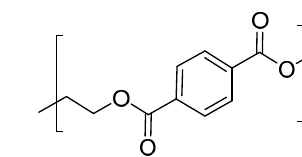
Figure 1. Chemical structures of ( a ) poly(ethylene vanillate) (PEV) and ( b ) poly(ethylene terephthalate) (PET).